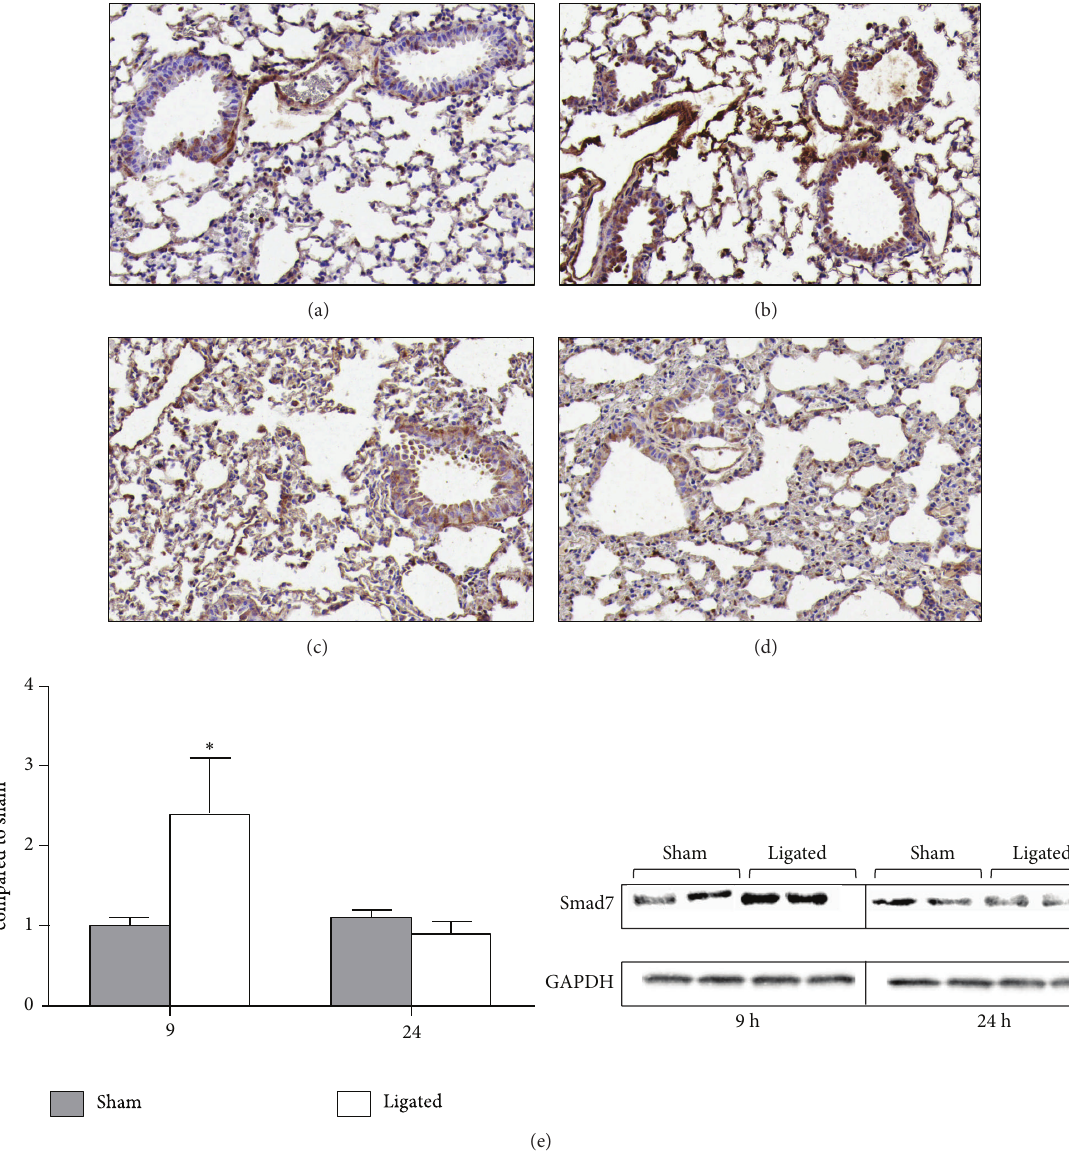
Figure 4: Transient induction of inhibitory Smad7 in the lungs. Representative images of Smad7 levels in lung tissue at 9h (a and b) and 24 h (c and d) following sham operation (a and c) and acute pancreatitis induction (b and d). Results from one representative of eight samples per group are shown. Original magnification, × 20. Western blot analysis of Smad7 protein levels in lung extracts of sham-operated and ligated animals at two time points (e). Two of five similar analyses per group are shown. Graph displays densitometry measurement of fold difference in Smad7 levels compared to sham control and represents mean ± SEM of five samples per group (e). ∗ 𝑃 < 0.05